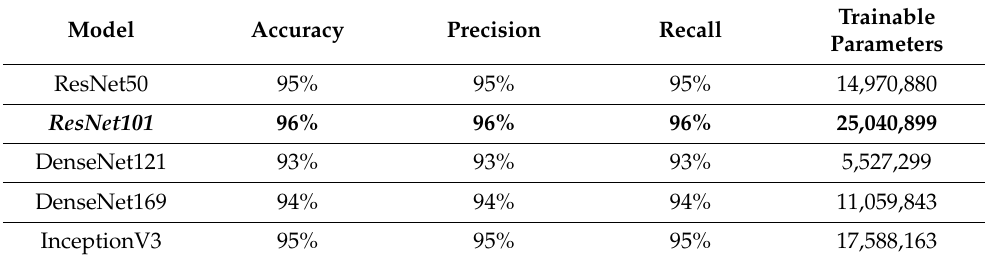
Table 8. Compiled Results from all